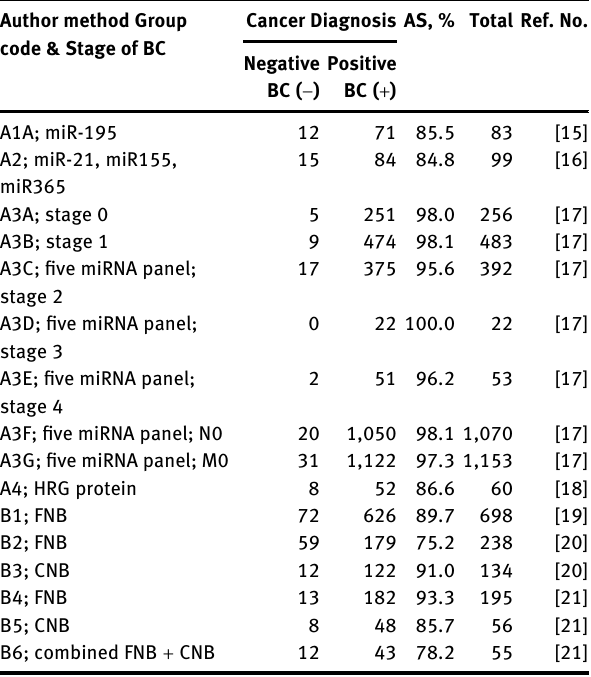
Table  : Absolute sensitivities (%), mis- (MD) and correct diagnosis (CD) in MM and FNB studies with BC patients. Cancer Diagnosis AS, % Total Ref. No.